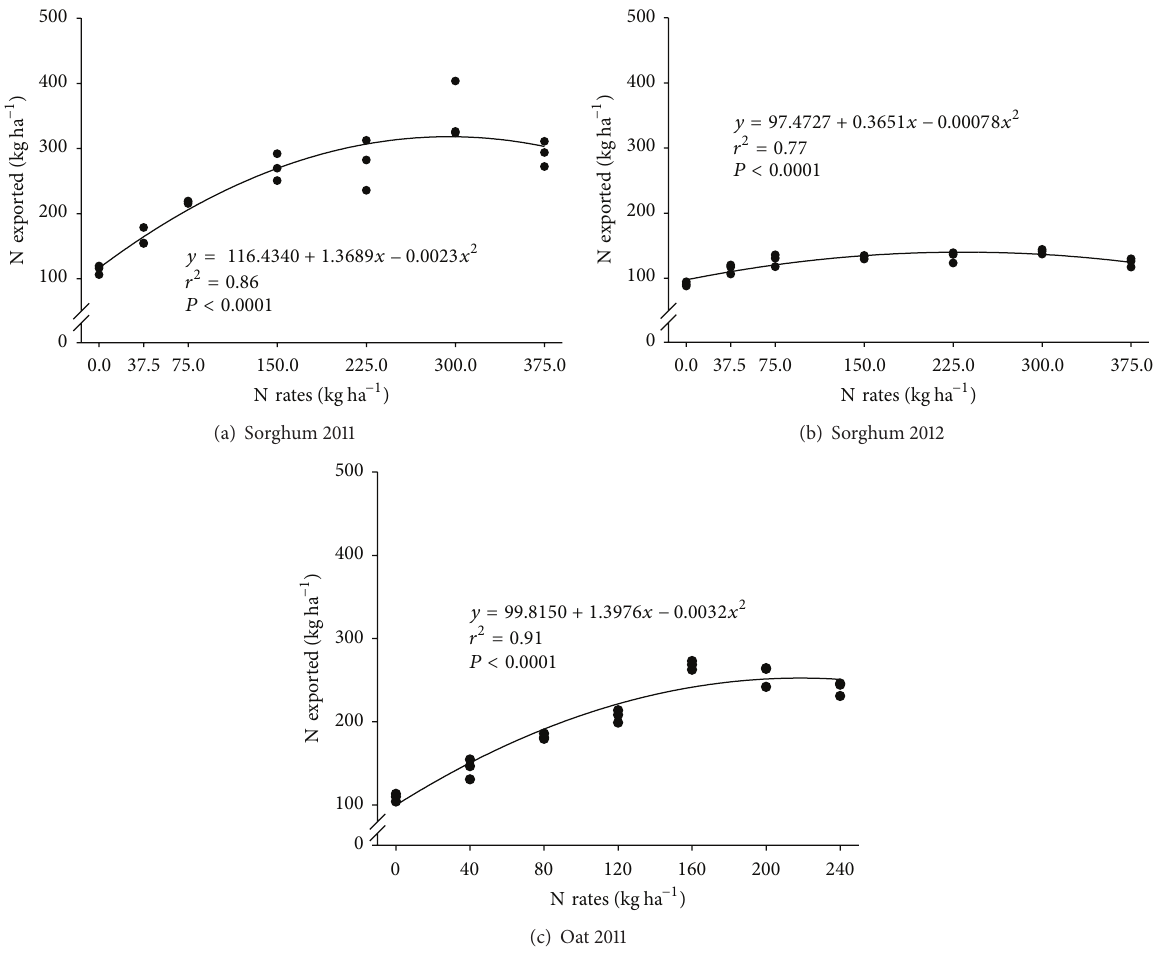
Figure 3: Nitrogen exported by the forage harvest of sorghum in the summer seasons of 2010/2011 (a) and 2011/2012 (b) and black oat in the winter season of 2011 (c), under nitrogen